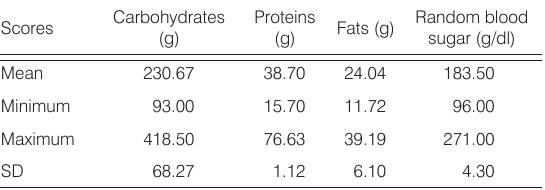
Table 1. Average intake of carbohydrates, proteins, and fats and blood sugar levels.